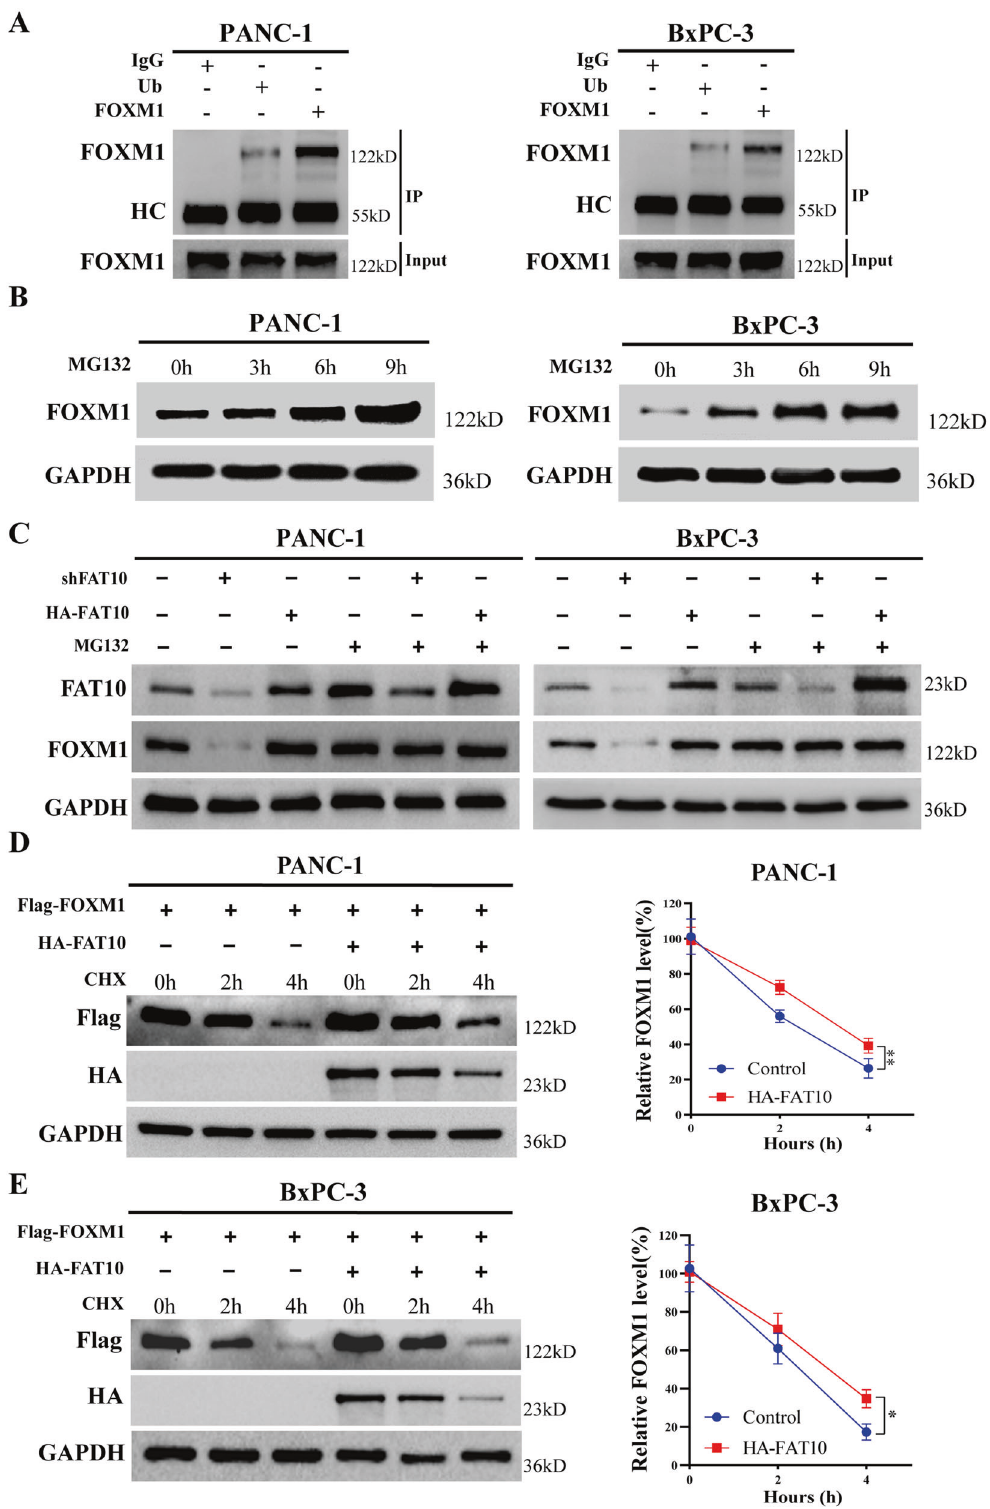
Fig. 6 FAT10 increases FOXM1 protein levels by inhibiting the ubiquitination and degradation of FOXM1 in PC cells. A Co-IP was used to detect the interaction between FOXM1 and ubiquitin in PANC-1 and BxPC-3 cells. HC, heavy chain. B With MG132 (10 μ M) added to PANC-1 and BxPC-3 cells, western blotting was used to detect protein levels of FOXM1 at different times. C MG132 (10 μ M) was added to PANC-1 and BxPC-3 cells while the expression of FAT10 was altered. Western blotting was used to detect protein expression levels of FOXM1. D PANC-1 and BxPC-3 cells were treated with CHX (20 μ M) for a speci fi ed time with or without the addition of the FAT10 overexpression plasmid, and FOXM1 protein levels were detected by western blotting. Data represent the mean ± SD of triplicate experiments and were statistically analyzed with Student ’ s t-test, * p < 0.05, ** p <